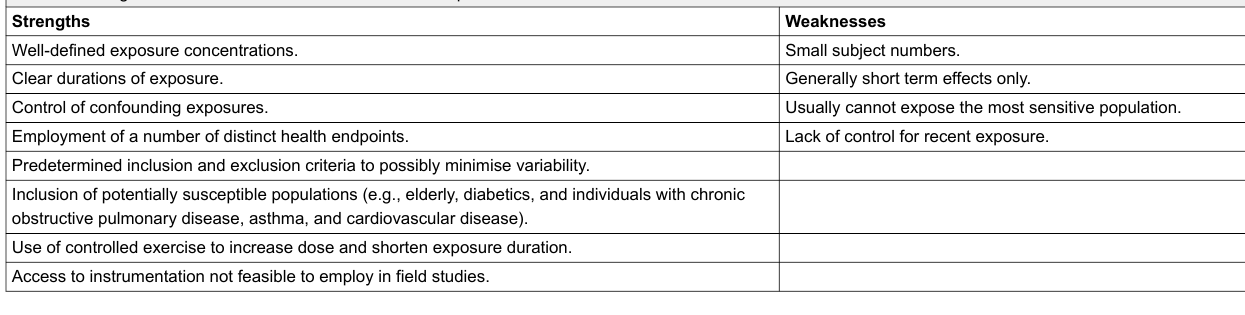
Table 2: Common environmental measurements obtained during controlled human exposure to diesel exhaust. Exposure chamber temperature Relative humidity Nitrogen dioxide Nitric oxide Sulfur dioxide Carbon monoxide Total hydrocarbons Particle mass concentration Particle number concentration Particle